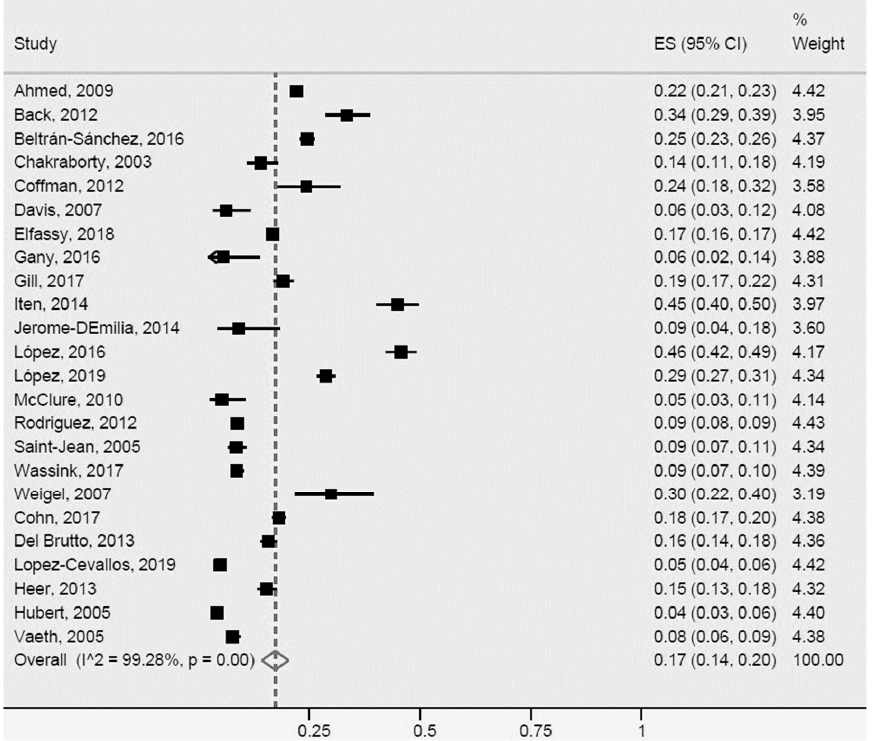
Figure 4. Type 2 diabetes mellitus or high blood glucose for Latinos in the US. ES = Estimated proportion/prevalence; CI = Confidence interval; I^2 = I 2 index.